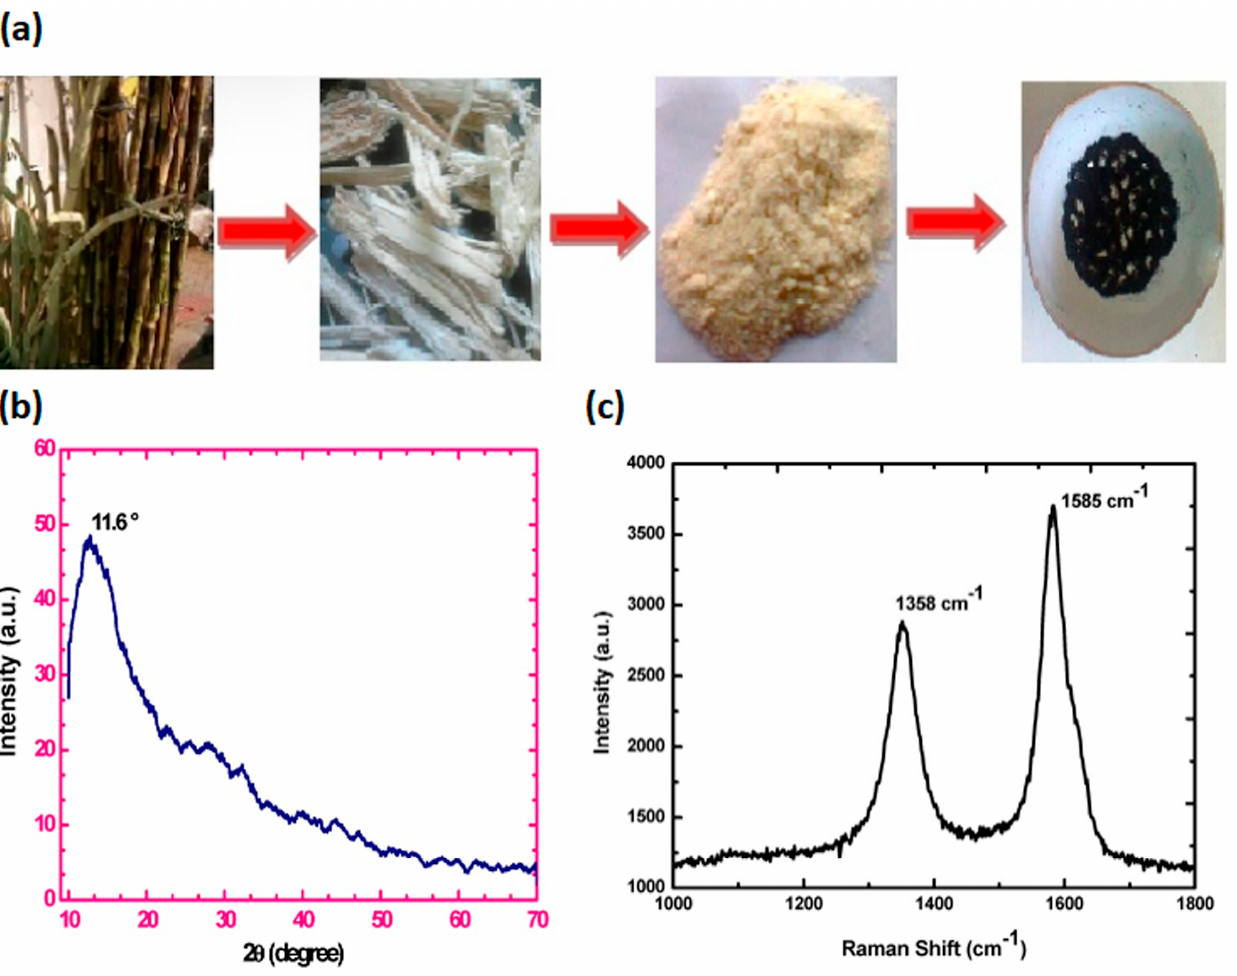
Figure 3. ( a ) Graphic scheme of sugarcane bagasse wastes conversion to GO; ( b ) X-ray diffraction (XRD) pattern; and ( c ) Raman spectrum of bagasse waste-derived GO, adapted from [91]. Copyright © 2015 by the authors; licensee MDPI, Basel, Switzerland.